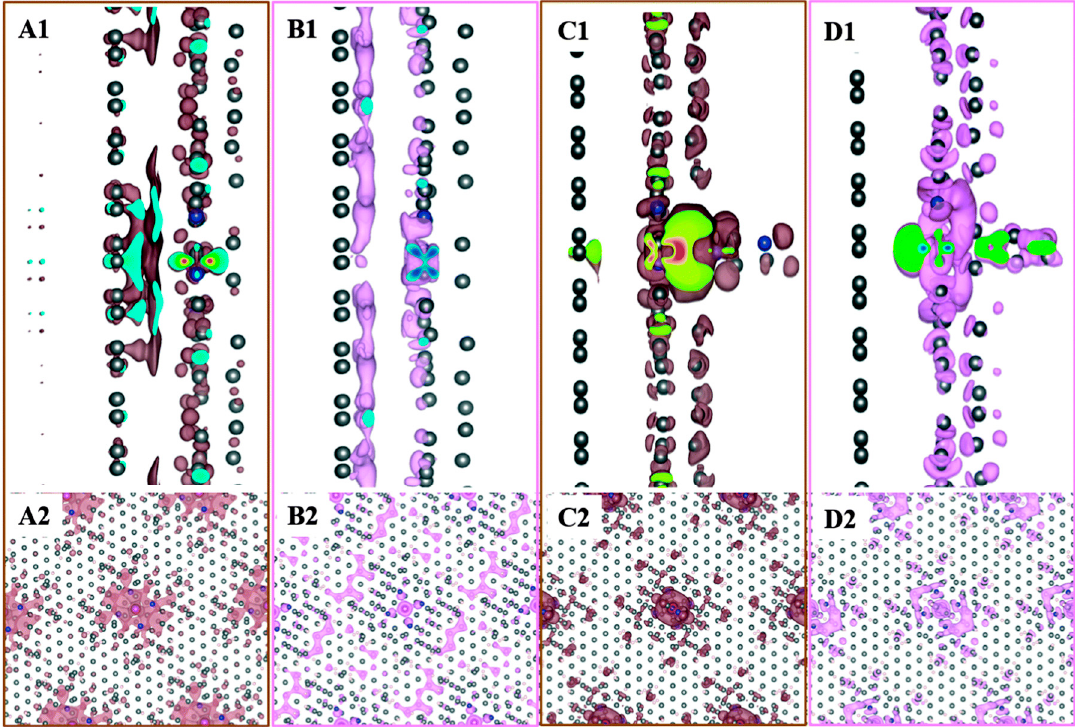
Figure 10. From left to right, charge density difference mappings for positive (colored in brown) and negative (colored in pink) charges for NiOEP/HOPG (A and B) and Im-NiOEP/HOPG (C and D) systems respectively. The images in the top row ( A1 – D1 ) represent side-view (along the a-axis) and the bottom row ( A2 – D2 ) represent top-view (along c-axis). Element colors are carbon—gray, nitrogen—blue, nickel—yellow (not visible). Hydrogens are masked for clarity. In the cross-section ( A1 – D1 , top row) the rainbow colors (blue to red) indicate charge with blue being highly negative and red being highly positive. Reproduced from reference [106] published by the PCCP Owner Societies.